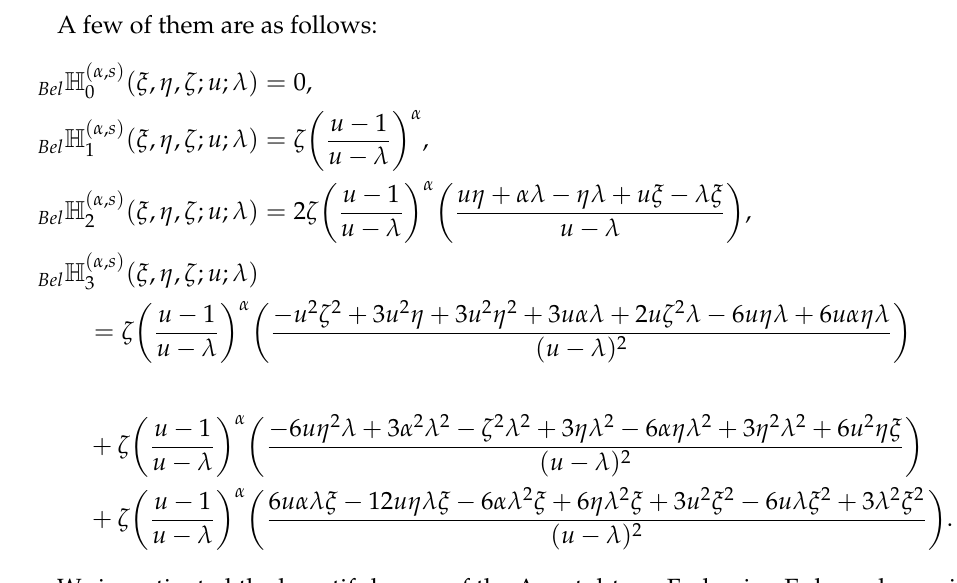
Figure 5. Zeros of Bel H